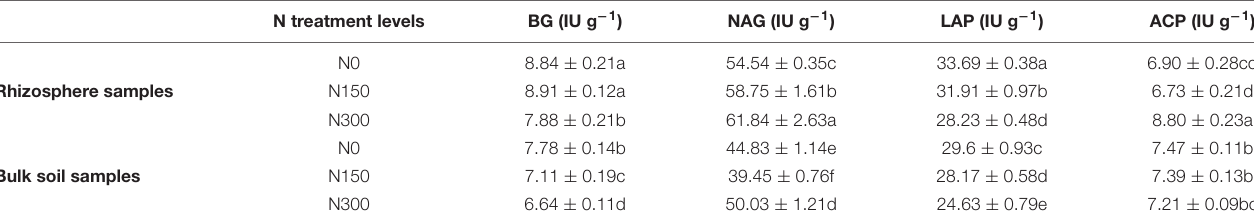
TABLE 4 | Activity levels of carbon (C)-, nitrogen (N)-, and phosphorus (P)-acquiring enzymes in rhizosphere and bulk soil samples subjected to the three nitrogen (N) fertilization levels. N treatment